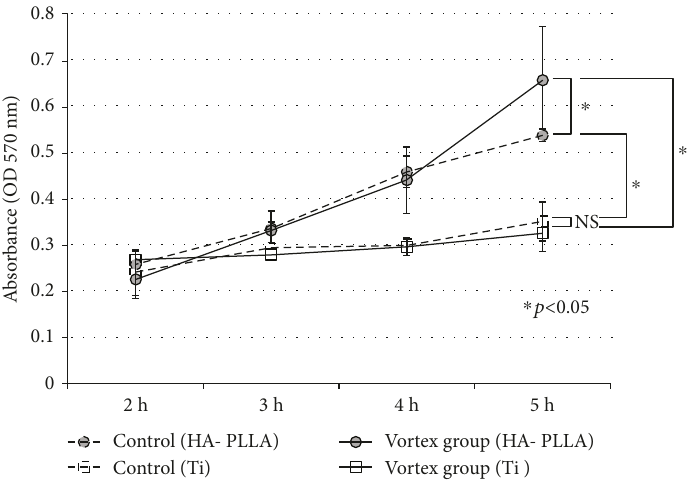
Figure 3: The growth of residual bacteria on Ti and HA-PLLA. No signi fi cant di ff erence was detected between vortex and control groups in both materials until 2 – 3 hours after 30s washing with DW. In contrast, at 4 – 5 hours of incubation after 30 s washing with DW, more bacterial growth was observed on HA-PLLA compared with Ti in both groups. The error bars represent the standard deviation. Values are mean ± SD from 3 samples per group. ∗ p < 0 05 . Circle shows HA-PLLA and square shows Ti as control.